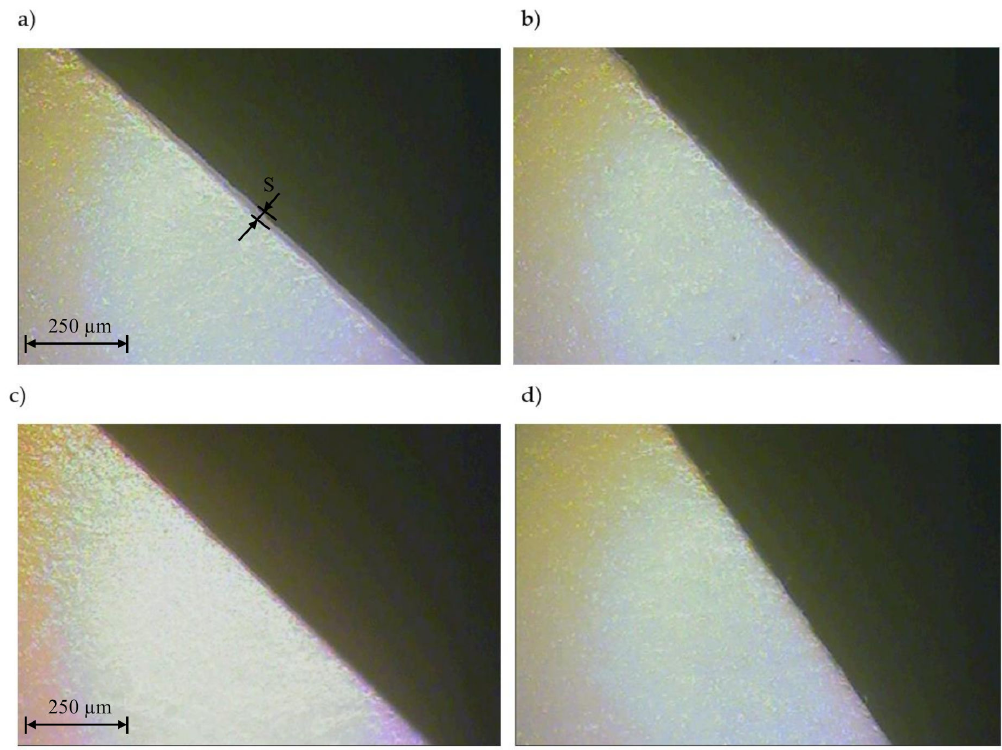
Figure 18. View of cut surface of foil thicknesses: ( a ) t = 50 µ m, ( b ) t = 60 µ m, ( c ) t = 70 µ m, ( d ) t = 80 µ